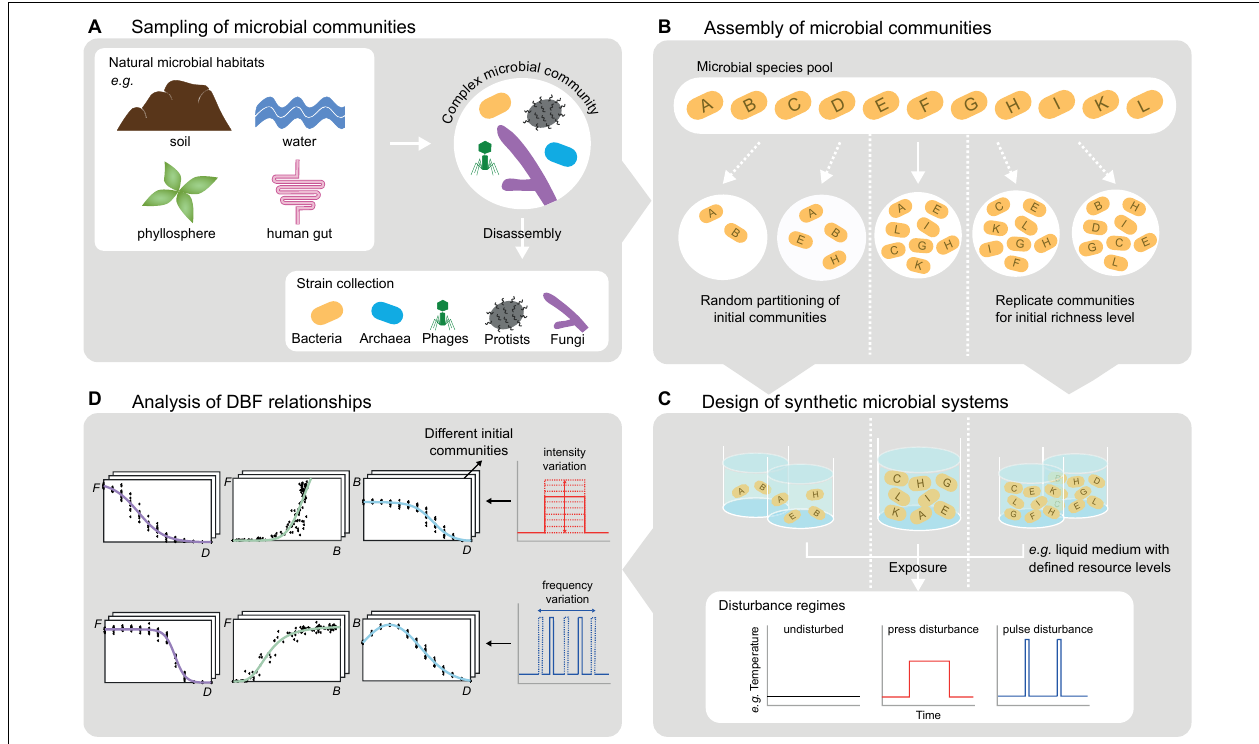
FIGURE 2 | Experimental considerations for studying DBF relationships with microbial systems. (A) Complex microbial communities obtained from environmental samples can be used directly or further be disassembled leading to comprehensive, well-characterized culture collections (cf. section “Choice and Assembly of Microbial Communities”). (B) Such collections enable targeted assembly of initial communities differing e.g., in species richness, evenness, or trait composition. Random partitioning of the species pool allows for varying biodiversity and for replicates with equal biodiversity level but different species (cf. section “Choice and Assembly of Microbial Communities”). (C) Incubated in synthetic microbial ecosystems (e.g., liquid cultures, but also more complex spatially structured systems), the communities can be exposed to disturbance regimes varying in type, frequency and intensity of disturbances, including disturbance combinations (cf. section “Application of Disturbance Regimes”). (D) Monitoring community compositions and (multiple) functions at several points in time reveals DBF relationships. This includes systematic variation of disturbance characteristics (e.g., frequency or intensity) and initial communities (cf. section “Observation of biodiversity and ecosystem functioning”). The experimental observations are a formidable starting point for computational modeling (cf. section “Computational Analysis and Modeling of DBF